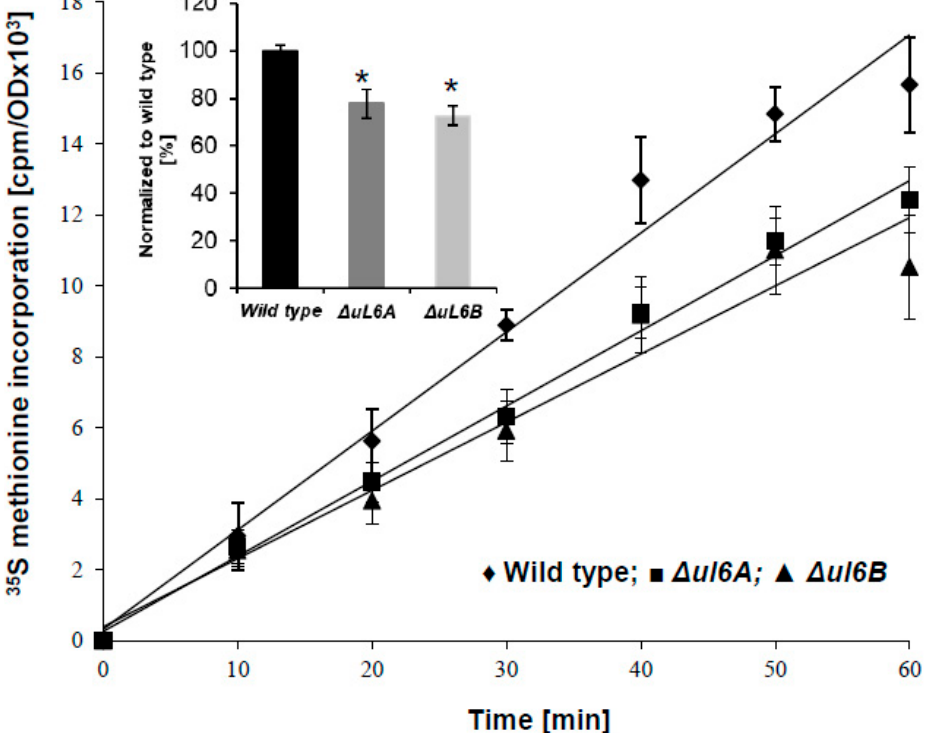
Figure 3. Translational fitness determined as a function of [35S]-methionine incorporation. Wild type strain-filled diamonds, ∆ ul6A strain-filled squares, and ∆ ul6B -filled triangles. Error bars represent standard deviations obtained from three independent experiments. Inset: Translational efficiency normalized to non-treated cells, error bars, SEM ( n = 3), * p < 0.01 Student’s test.